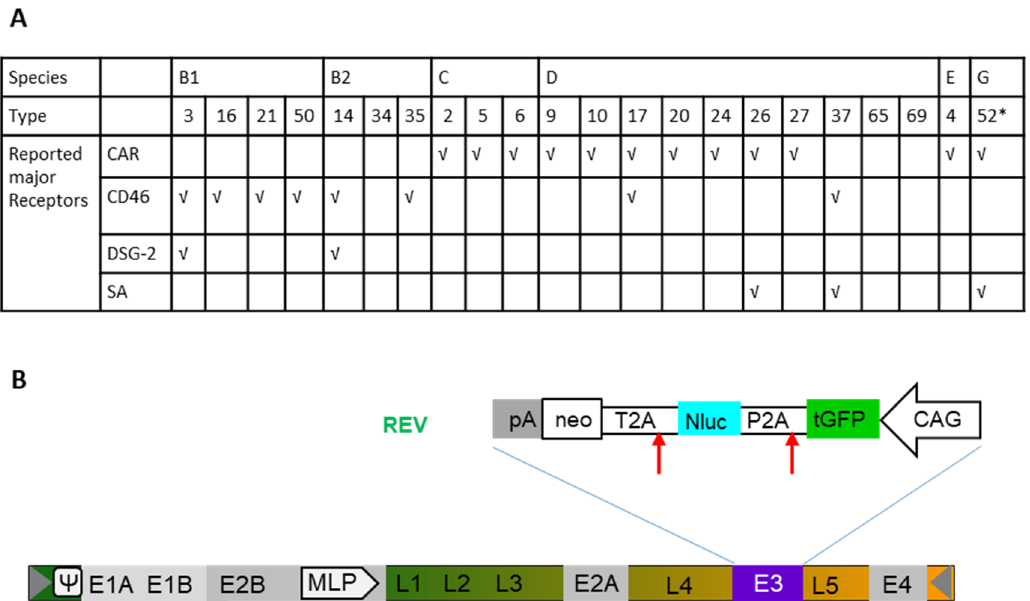
Figure 1. Reporter-labelled human adenoviruses (Ads). ( A ) Overall, 22 adenovirus types (Ad type number) from 6 species were used in transduction of breast cancer (BC)-related cells. The previously reported receptor usage is indicated ( √ ). ( B ) Construction of human Ad expressing turbo green fluorescent protein (tGFP), nanoluciferase (Nluc), and neomycin resistance (neo) under the control of the hybrid construct consisting of the cytomegalovirus (CMV) enhancer fused to the chicken beta-actin promoter (CAG) This cassette was inserted in the E3 genomic region. *, it is of note that Ad52 used here is only labelled with turbo GFP (tGFP)-neo. Therefore, Ad52 is not presented in luciferase-based assays.